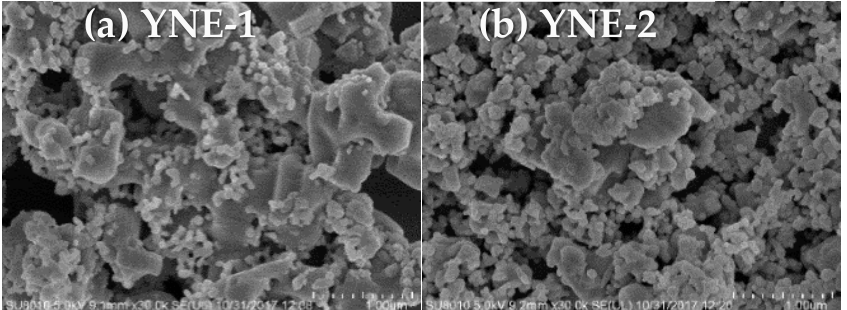
Figure 2. SEM images of YbNbO 4 :Er 3+ ( a )YNE-1, ( b )YNE-2.